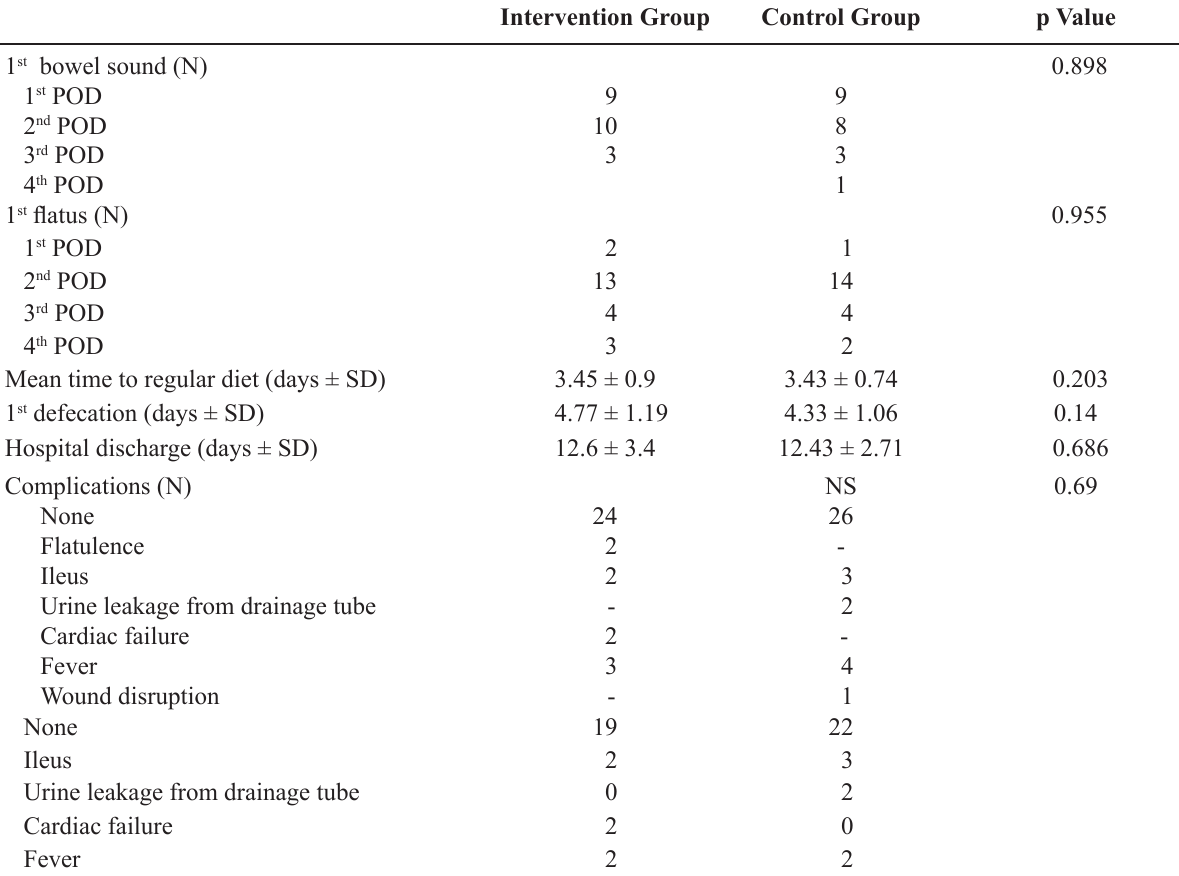
Table 3 – Outcomes.